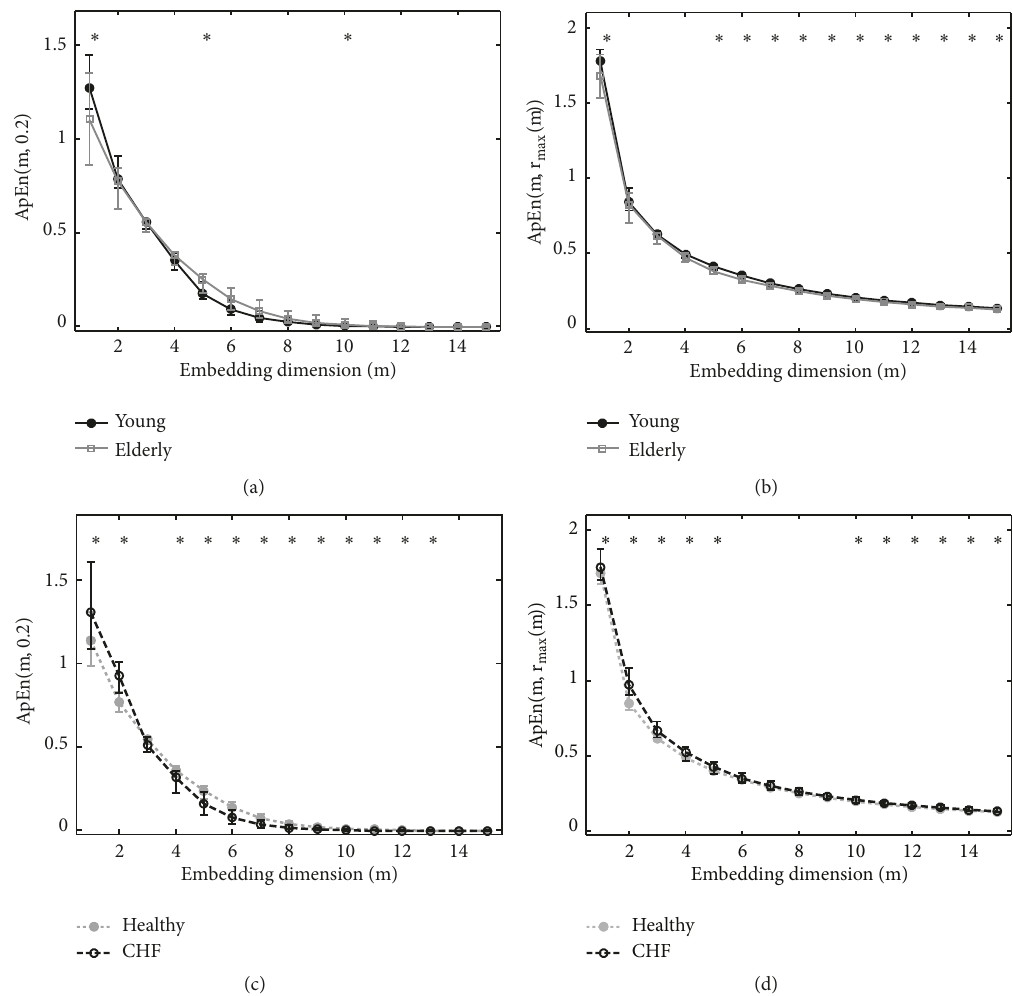
Figure 8: Approximate entropy values computed for thresholds set at 0.2 and r (m) across embedding dimensions in young (black) and max elderly (grey) groups shown in (a) and (b), and in healthy subjects (dotted grey) and CHF patients (dashed black) during the night period in (c) and (d). ∗ indicates statistically significant differences by Mann-Whitney U test ( p -values < 0.05) between groups for a given embedding dimension. Data are shown as median and interquartile range.